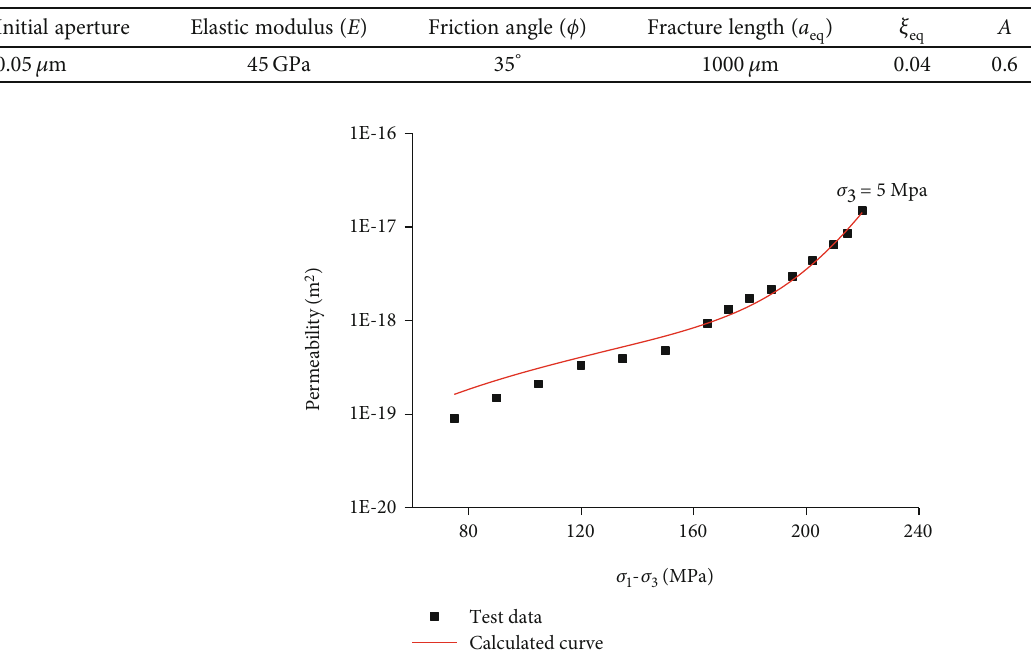
Figure 7: Comparisons between the observed curves (from Ref. [45]) and theoretical results from Eq.